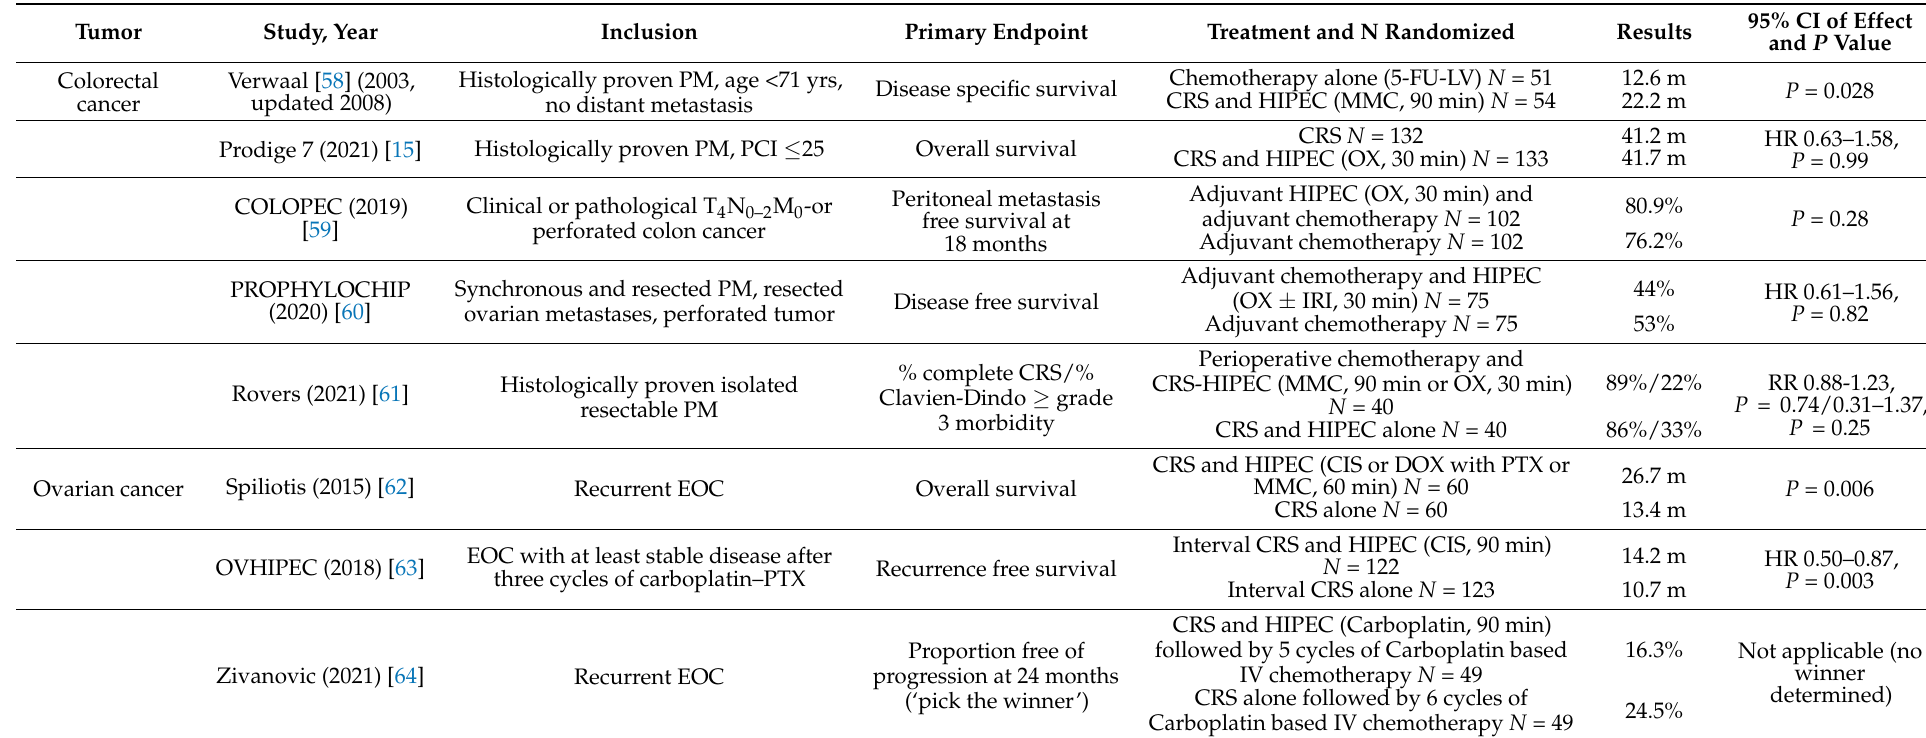
Table 1. Overview of randomized trials comparing surgery combined with HIPEC versus surgery